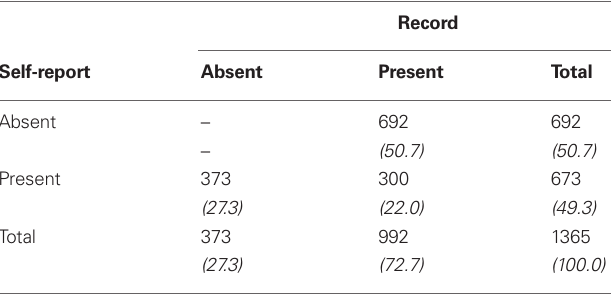
Table 1 | Concordance among 1365 illnesses recorded over the 11-year follow-up